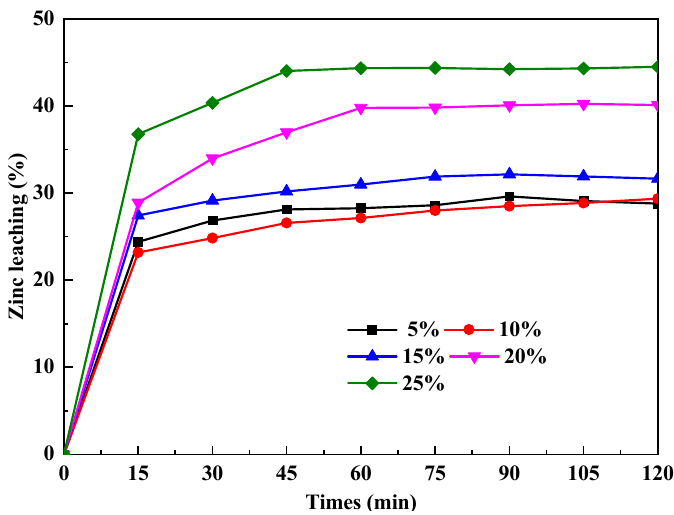
Figure 7. The effects of the Na 2 O 2 doping concentration on zinc leaching under conventional